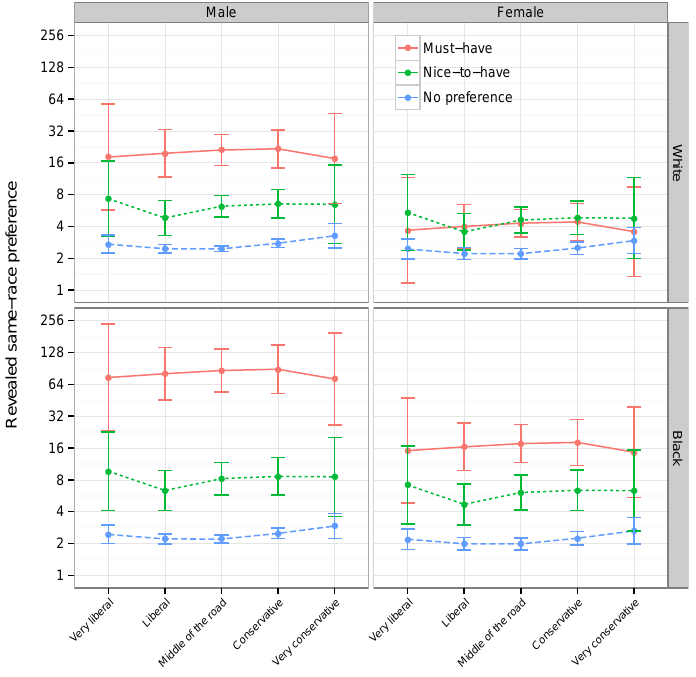
Figure 5: Estimated revealed preferences for same-race partners by stated same-race preference. Bars indicate 95 percent confidence